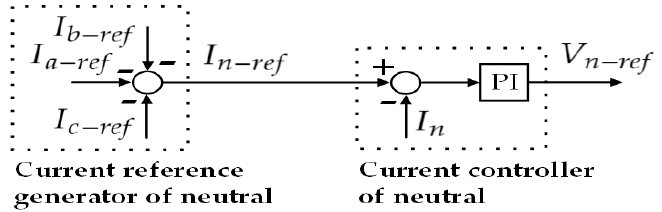
Figure 5. Control diagram of the current control for “neutral”.